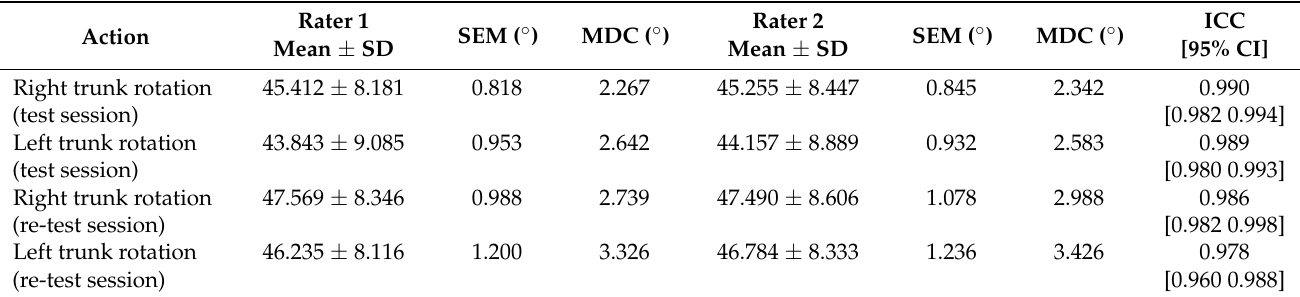
Table 1. Inter-rater reliability of the MGP for left and right trunk rotations.